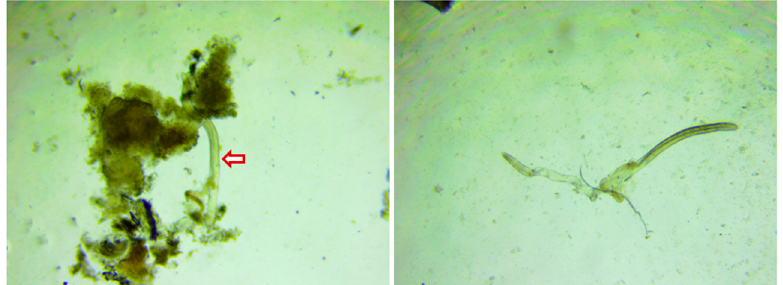
Figure 1. Microfilaria in humpsore-infected skin scraping (40×). Pinch of skin from the infected animal was collected in phosphate buffered saline (PBS) and transported to the laboratory. The skin scraping was minced in PBS and concentrated by centrifugation (250× g ) for 15 min and sedi- ment was examined under 40× magnification. was examined under 40 ×